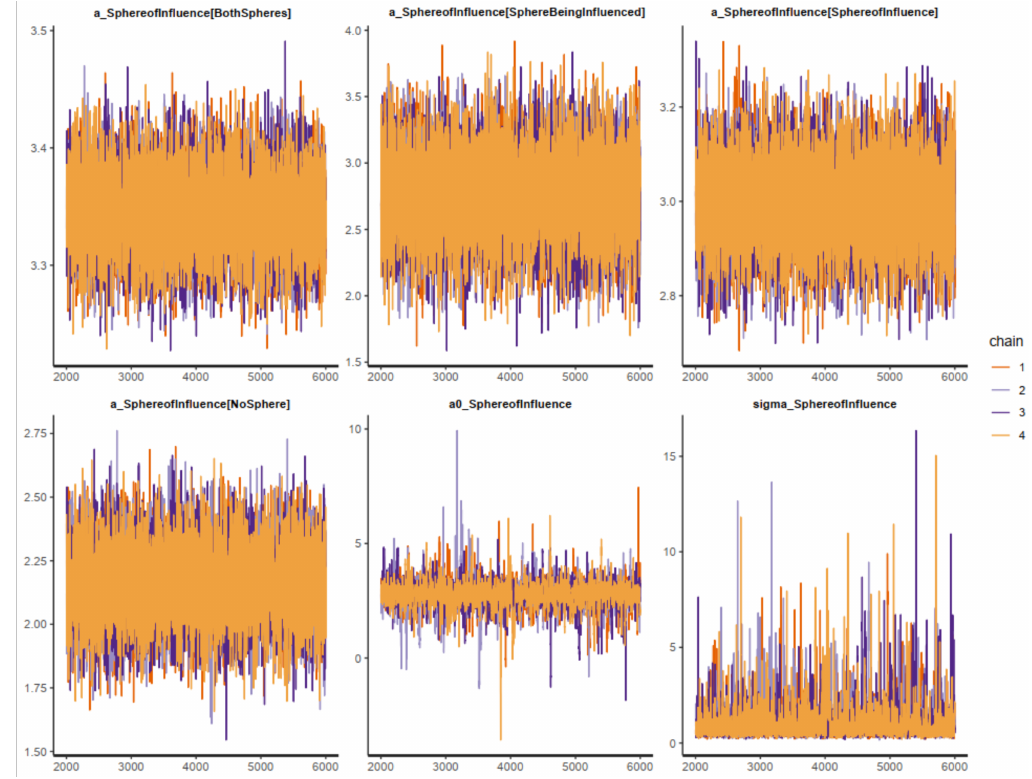
Figure A10. Model 4 (cid:48) s trace plots.